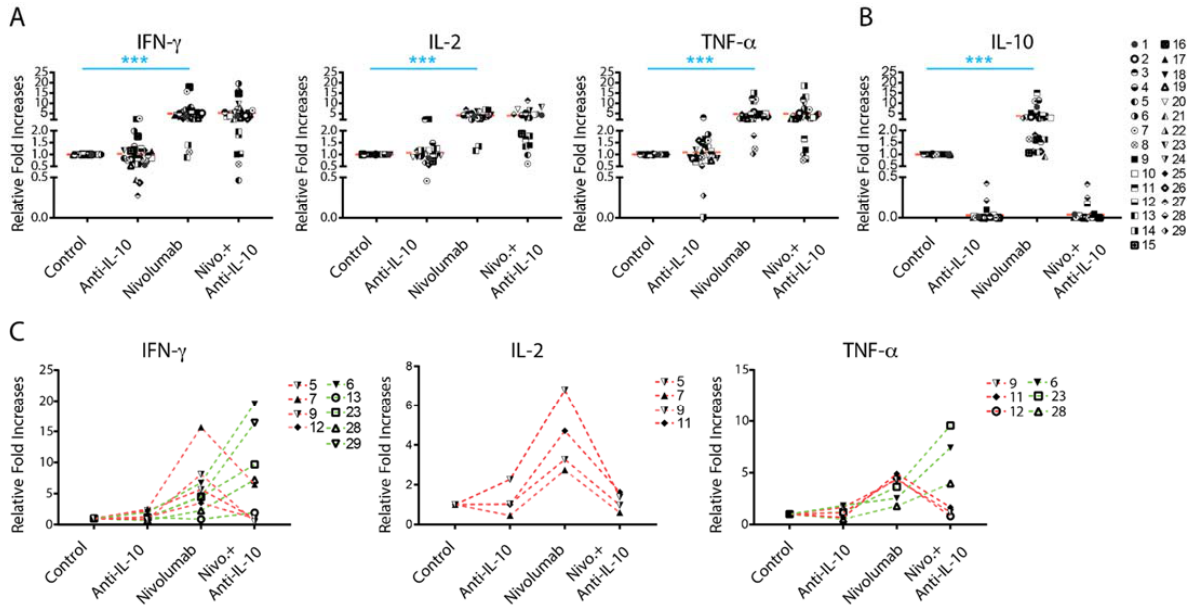
Figure 2. Anti ‐ interleukin ‐ 10 (anti ‐ IL ‐ 10) mAb induces heterogeneous cytokine responses. ( A , B ) Purified T cells were co ‐ cultured with allogeneic matured monocyte ‐ derived dendritic cells in the presence of nivolumab (20 μ g/mL) with or without anti ‐ IL ‐ 10 mAb (5 μ g/mL) for 5 days, after which the culture media was harvested for multiplex analysis of the production of interferon ‐γ (IFN ‐γ ), IL ‐ 2 and tumor necrosis factor ‐α (TNF ‐α ), ( A ) and IL ‐ 10 ( B ). Graphics charting the relative fold change over the no ‐ antibody treatment controls per donor pair. ( C ) Donor pairs with two ‐ fold changes between nivolumab and nivolumab plus anti ‐ IL10 mAb treatment are shown. Each symbol represents data from one individual donor pair. Student’s t ‐ test, *** p < 0.001.